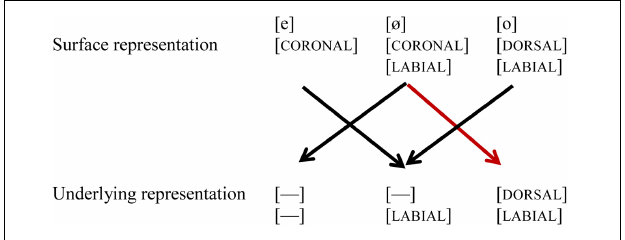
FIGURE 1 | Black lines indicate a no-mismatch, the red line indicates a mismatch. [—] indicates underspecification.